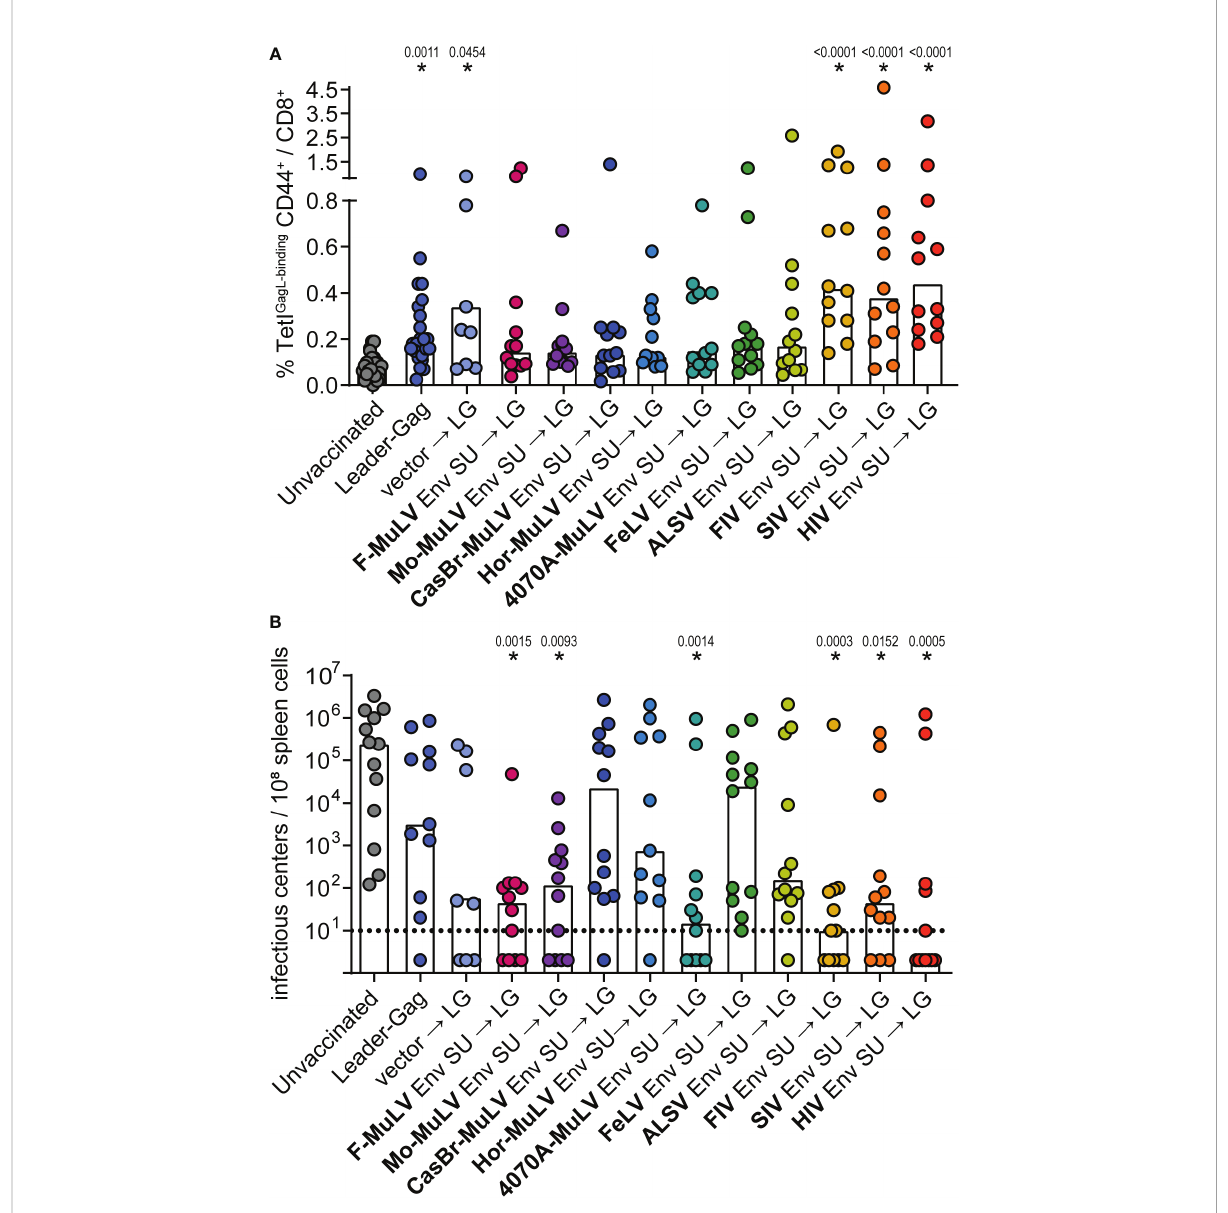
FIGURE 8 F-MuLV Leader-Gag-speci fi c CD8 + T-cell responses after preceding immunization with different Env SU-encoding plasmids. CB6F1 mice were immunized once with 25 µg of a plasmid encoding SU Env of F-MuLV, Mo-MuLV, CasBr-MuLV, Hor-MuLV, 4070A-MuLV, FeLV, ALSV, FIV, SIV, or HIV or a control plasmid, followed 3 weeks later by vaccination with 25 µg of pCG.Leader-Gag. Two weeks after the second immunization, the frequency of GagL 85-93 -speci fi c CD8 + T cells was analyzed in peripheral blood (A) . Three weeks after the second vaccination, the mice were infected with 5,000 SFFU FV by intravenous injection. Three weeks after the FV challenge, the mice were sacri fi ced and the viral loads in the spleens were determined (B) . Data from 8 to 12 (A: 8 to 24) mice per group were acquired in two to three independent experiments. Each dot indicates an individual mouse, and bars indicate mean (A) or median values (B) . Statistically signi fi cant differences compared with the unvaccinated group are indicated by * ( p < 0.05, Kruskal – Wallis one-way ANOVA on ranks, Dunn ’ s